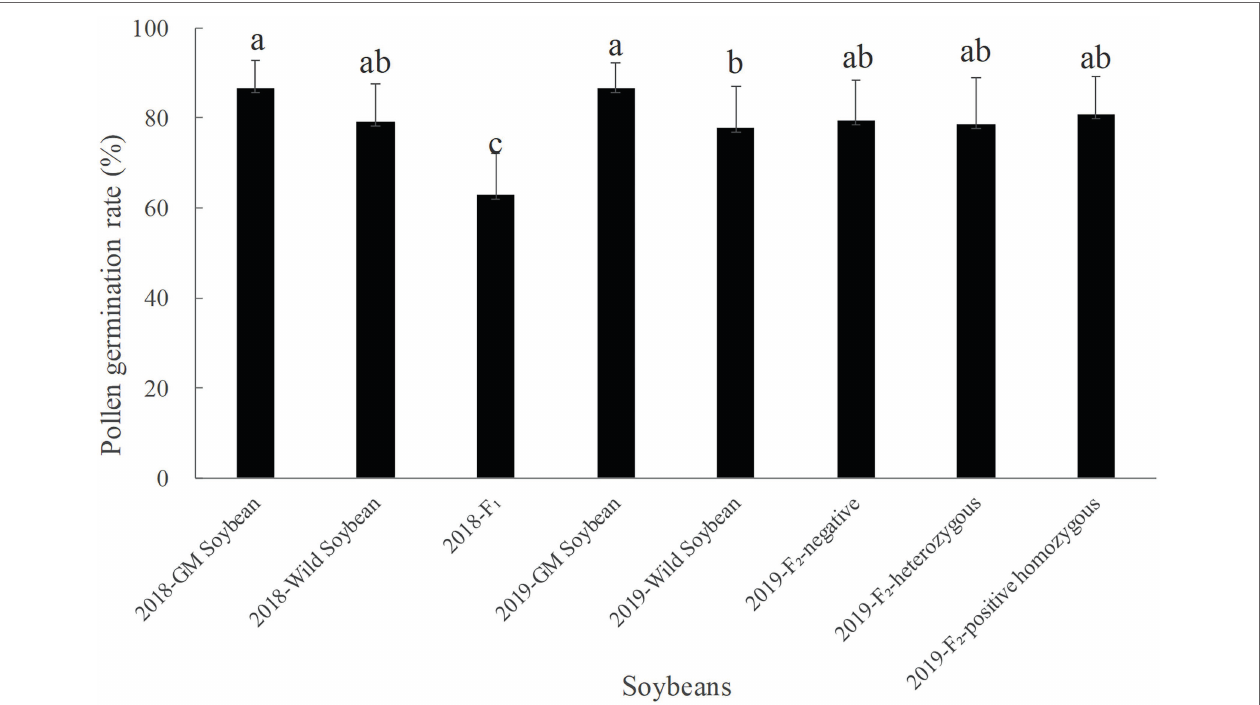
FIGURE 4 | Pollen germination rate (%) of transgenic, wild soybeans, and hybrid